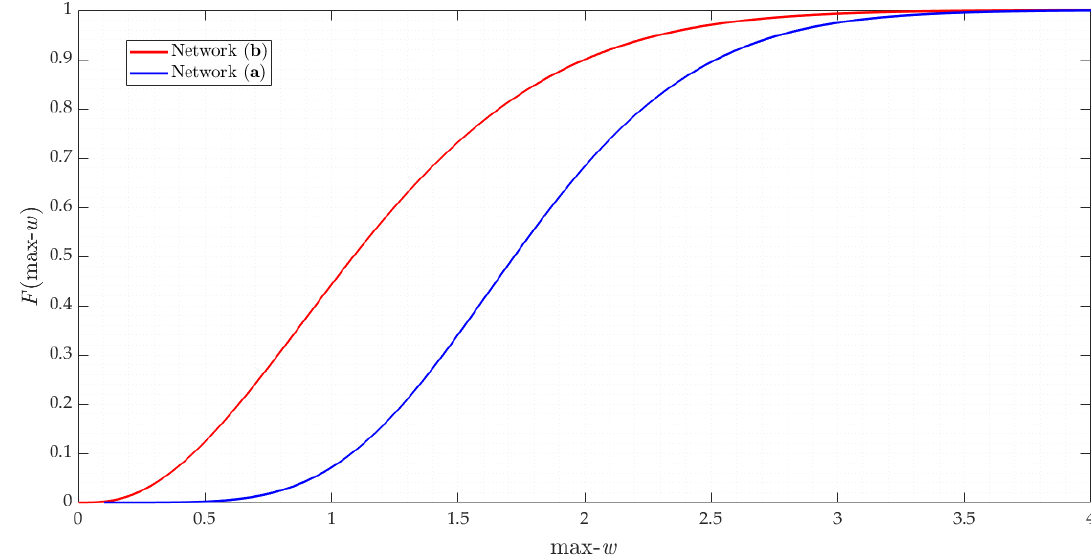
Figure 7. Cumulative frequency of max- w for networks ( a ) in blue and ( b ) in red.